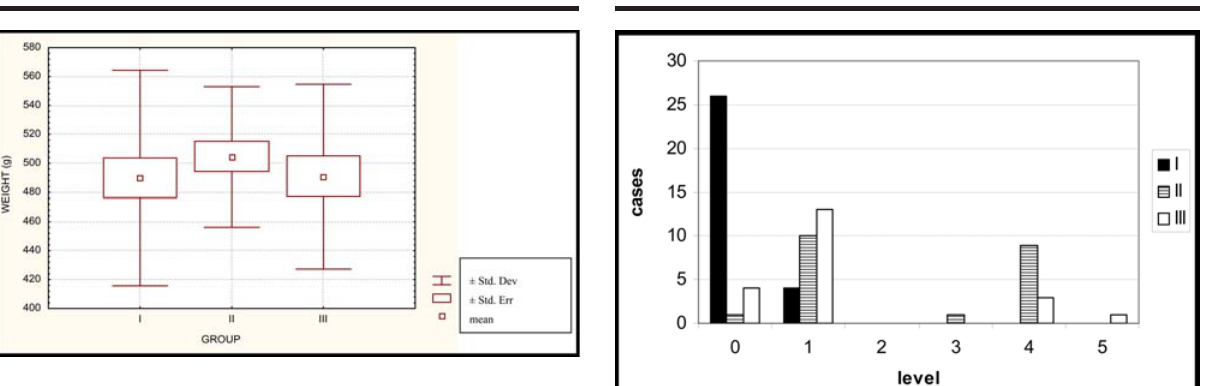
FIGURE 9 - Animals’ weights on euthanasia day, distributed in groups. I. control; II. polypropylene; III. latex coated polypropylene